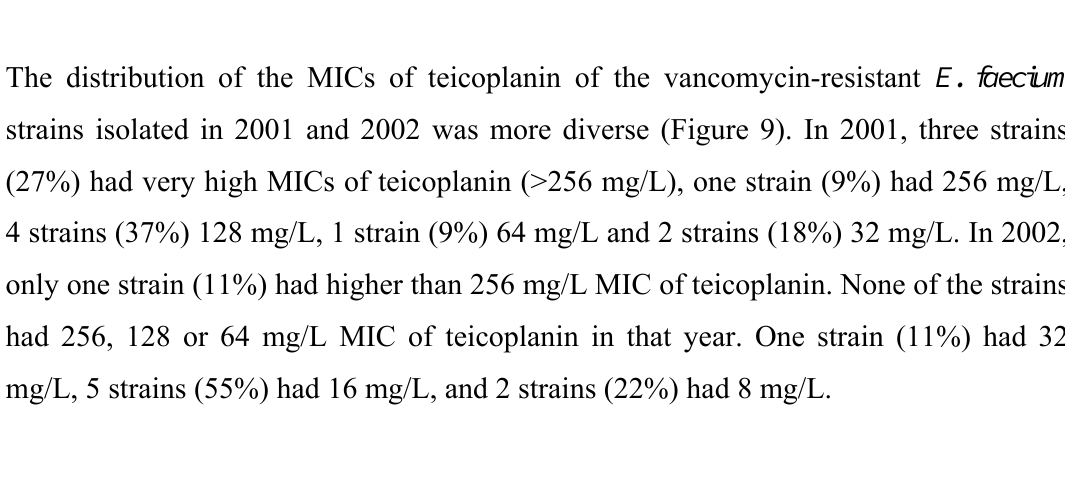
Figure 8. Distribution of the vancomycin MICs of the vanA positive E. faecium strains, isolated in 2001-2002